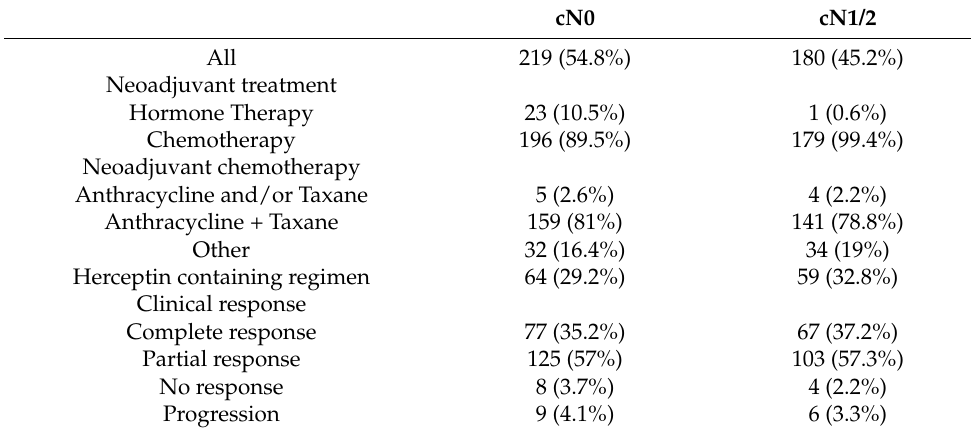
Table 2. Schemes of delivered neoadjuvant treatments according to axillary clinical stage at diagnosis and related clinical response.